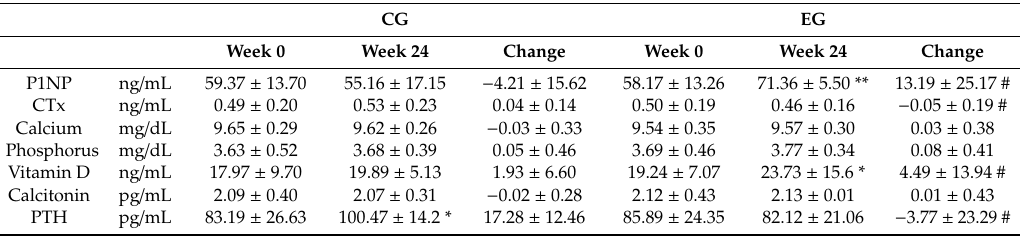
Table 5. Biochemical parameters of bone metabolism of the study participants before and after the intervention. CG EG Week 0 Week 24 Change Week 0 Week 24 Change P1NP ng / mL 59.37 ± 13.70 55.16 ± 17.15 − 4.21 ± 15.62 58.17 ± 13.26 71.36 ± 5.50 ** 13.19 ± 25.17 # CTx ng / mL 0.49 ± 0.20 0.53 ± 0.23 0.04 ± 0.14 0.50 ± 0.19 0.46 ± 0.16 − 0.05 ± 0.19 # Calcium mg / dL 9.65 ± 0.29 9.62 ± 0.26 − 0.03 ± 0.33 9.54 ± 0.35 9.57 ± 0.30 0.03 ± 0.38 Phosphorus mg / dL 3.63 ± 0.52 3.68 ± 0.39 0.05 ± 0.46 3.69 ± 0.46 3.77 ± 0.34 0.08 ± 0.41 Vitamin D ng / mL 17.97 ± 9.70 19.89 ± 5.13 1.93 ± 6.60 19.24 ± 7.07 23.73 ± 15.6 * 4.49 ± 13.94 # Calcitonin pg / mL 2.09 ± 0.40 2.07 ± 0.31 − 0.02 ± 0.28 2.12 ± 0.43 2.13 ± 0.01 0.01 ± 0.43 PTH pg / mL 83.19 ± 26.63 100.47 ± 14.2 * 17.28 ± 12.46 85.89 ± 24.35 82.12 ± 21.06 − 3.77 ± 23.29